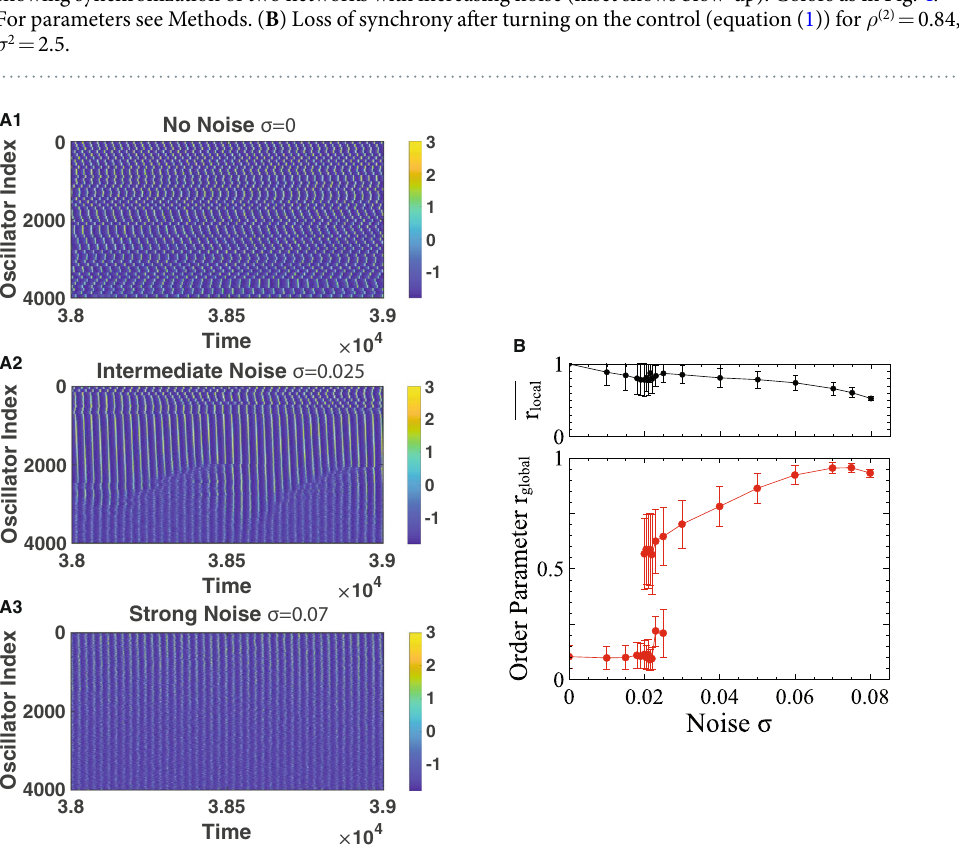
Figure 9. Noise synchronizes interconnected networks of relaxation oscillators. ( A ) Space-time diagram of α x t ( ) ( ) for 50 of the = 200  networks with N = 80 oscillators each. Networks are not synchronized for α i vanishing noise, σ = 0 ( A1 ). Partial, oscillatory synchronization for σ = 0.025 ( A2 ). Almost complete synchronization for σ = 0.07 ( A3 ). ( B ) Lower panel: temporal mean and standard deviation of the global order parameter r global showing a discontinuous transition to an ordered regime as the uncorrelated noise is increased. Upper panel: mean local order parameter r decreases with local to be via stereotpical inhibitory synaptic pulses that are triggered when V reaches a threshold of V θ = 10 mV and are described by equations (3 and 4). In these simulations we use a random, sparse connectivity in which each of the N α oscillators in each network has a fixed number  α N of randomly chosen incoming connections from the 1 of connections from the other network. Thus, oscillators within the same network and a lower, fixed number  α N 2 the in-degree, but not the out-degree, of each oscillator is fixed. Again, uncorrelated noise synchronizes the population rhythms (Fig. 8A). For the parameters in Fig. 8A rhythms other than 1:2 and 1:1 arise only for very small noise (inset of Fig. 8A). For other parameter values of the inhibition and for Morris-Lecar neurons of type 1 other phase-locked states can arise for weak noise. This is shown in Supplementary Figs S4 and S5, which also demonstrate the robustness of the synchronization. As found